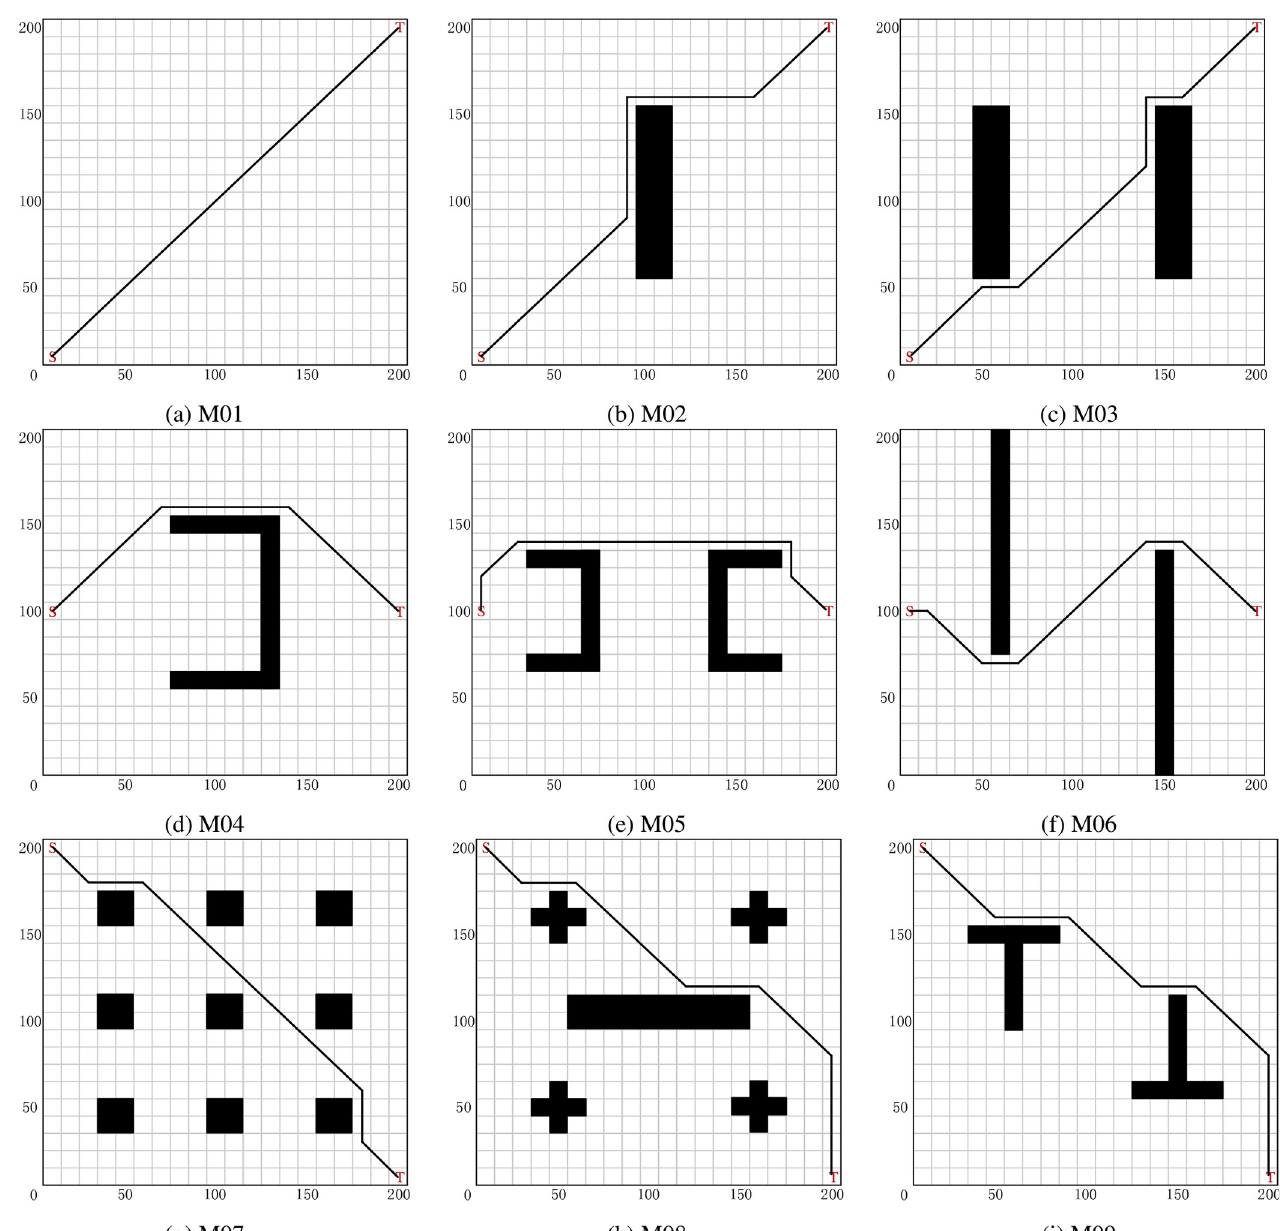
Fig 3. Short path planning (solution) for MR in different test environments (Each map shows the best path obtained by the SSQL algorithm, S is the starting point and T is the target point).